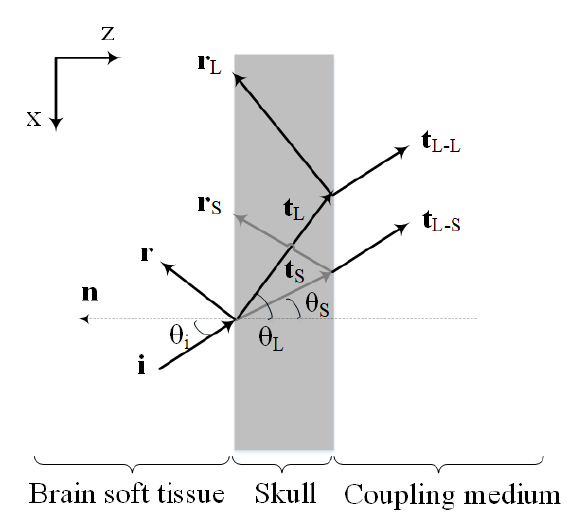
Figure 1. Schematic illustration of the PA wave transmission through the skull. The interfaces are assumed to be parallel with the Cartesian coordinates, where z is oriented orthogonal to the interfaces and x runs along the interface plane. Here, i denotes the incident ray direction vector, r denotes the reflected ray direction vector and t denotes the transmitted ray direction vector (the subscripts L and S refer to the longitudinal and shear rays, respectively). Also t L − L and t L − S are the longitudinal transmitted ray direction vectors generated by the incident longitudinal and shear rays in the skull, respectively. θ i , θ L and θ S are the angle of incidence, longitudinal transmittance, and shear transmittance, respectively. n is the normal vector orthogonal to the